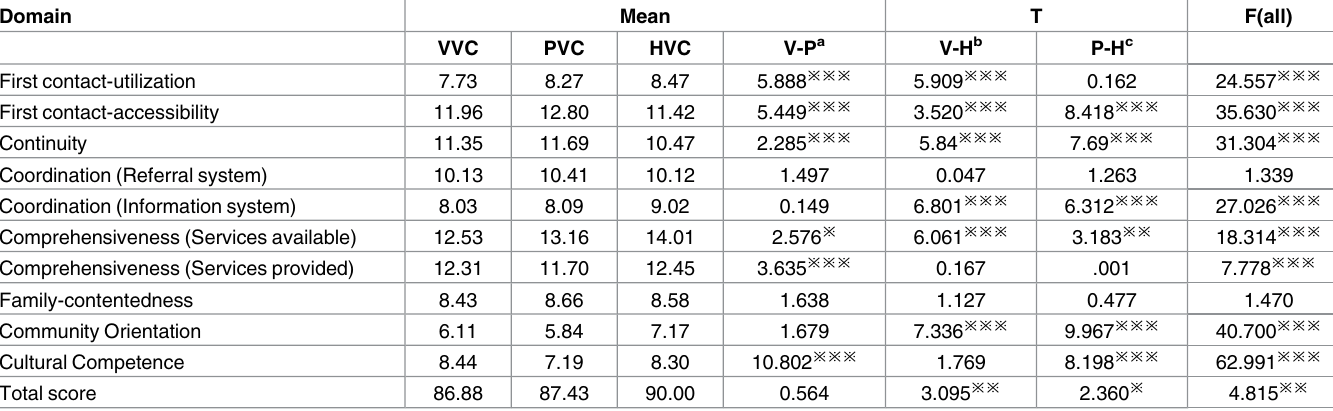
Table 3. Primary care quality scores for three types of VCs,